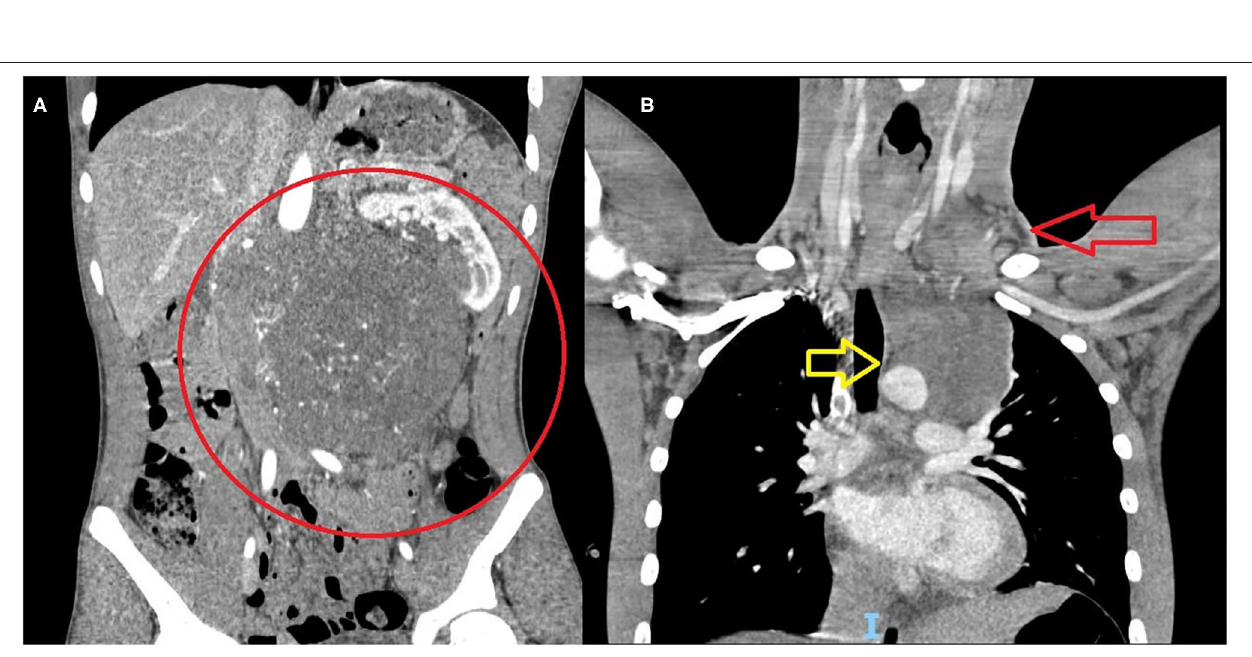
FIGURE 2 | Massive metastatic involvement of retroperitoneal (A) and mediastinal (B) lymph-nodes.